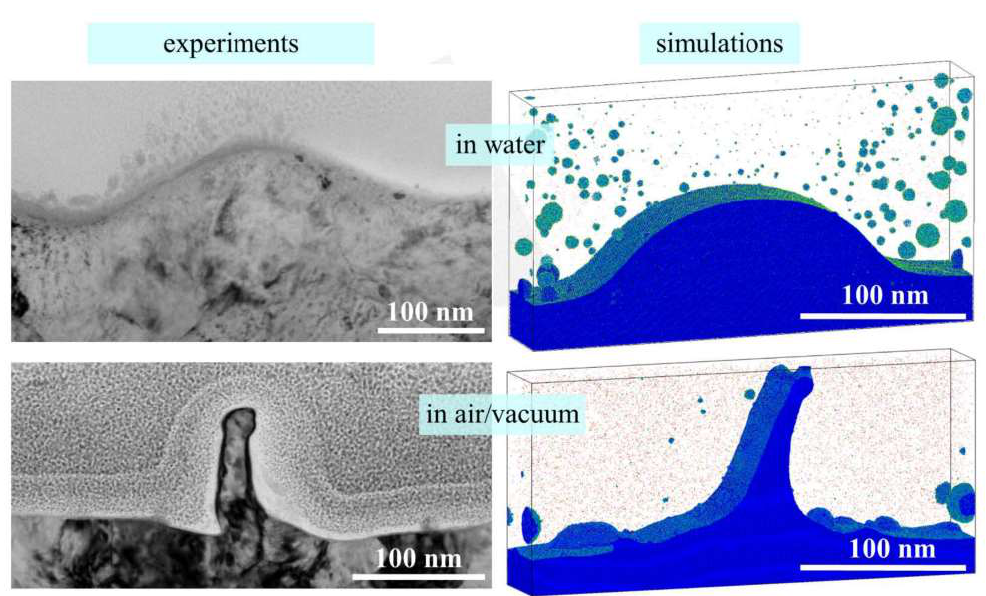
Figure 3. LIPSS structure comparison between the experiment and TTM-MD simulation [19]. Reprinted with permission from Ref. [19]. Copyright 2020 Royal Society of Chemistry.